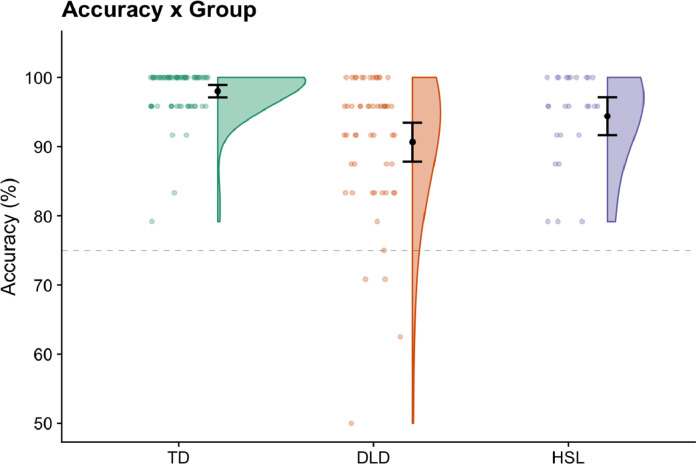
Accuracy scores for verb generation in typically developing (TD) children (in green), those with developmental language disorder or DLD (orange), and those with a history of speech and language disorder or HSL (in purple) are depicted using violin plots. Plots show mean +/- 95% confidence intervals. Individual data is shown alongside; data are jittered along the X axis for visualisation purposes. Dotted line indicates our performance cut off for inclusion in analyses. The four individuals below the cut off were only retained for the performance sub-group analyses (see text and later figures).